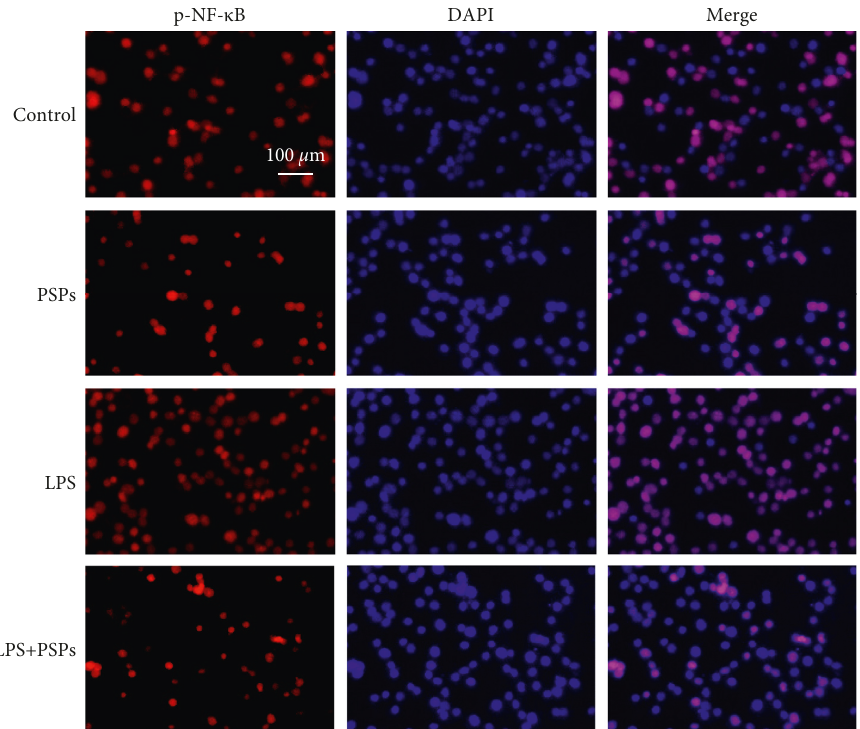
Figure 7: Effect of PSPs treatment on NF- κ B nuclear translocation. Magnification: 10x, scale: 100 μ